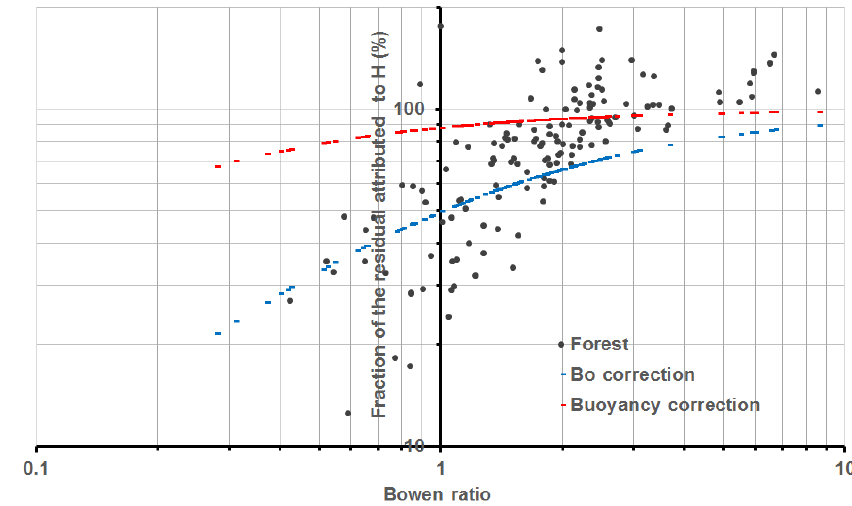
Figure 6. Fraction of the residual attributed to the sensible heat flux for the forest site (GDP 1, 2, and 3), under the assumption that the model calculated the true Bowen ratio, and according to the correction methods with the Bowen ratio (Twine et al., 2000) and the buoyancy flux (Charuchittipan et al.,